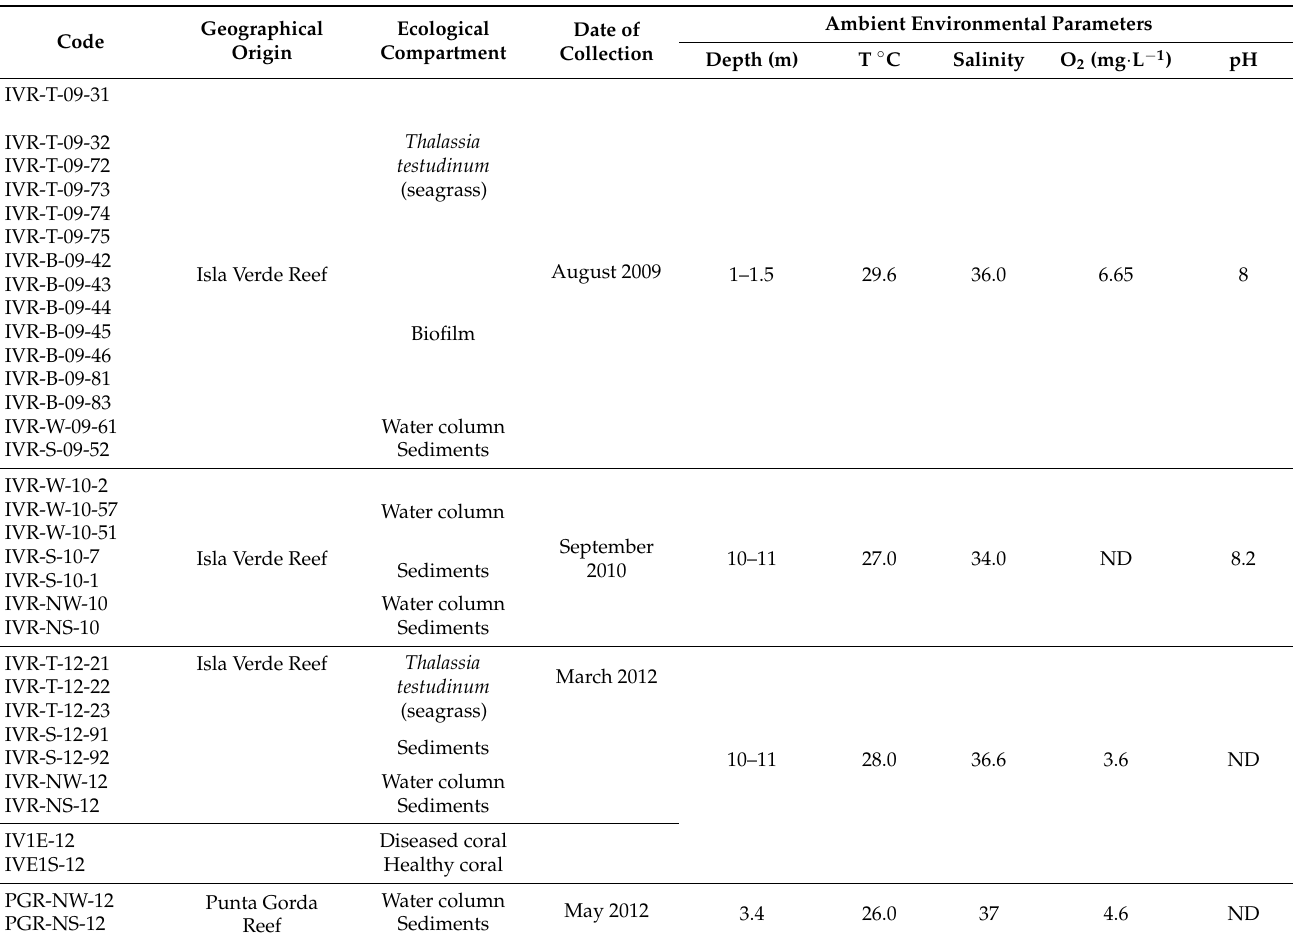
Table 1. Cultured bacterial isolates from the Veracruz Reef System indicating geographical location and ambient environ- mental parameters of field sampling for isolation. IVR = Isla Verde Reef; PGR = Punta Gorda Reef; T = Thalassia testudinum ; B = uncharacterized biofilm; W = water column; S = substrate; N = natural (non-cultured). Other designations are laboratory codes for field samples or